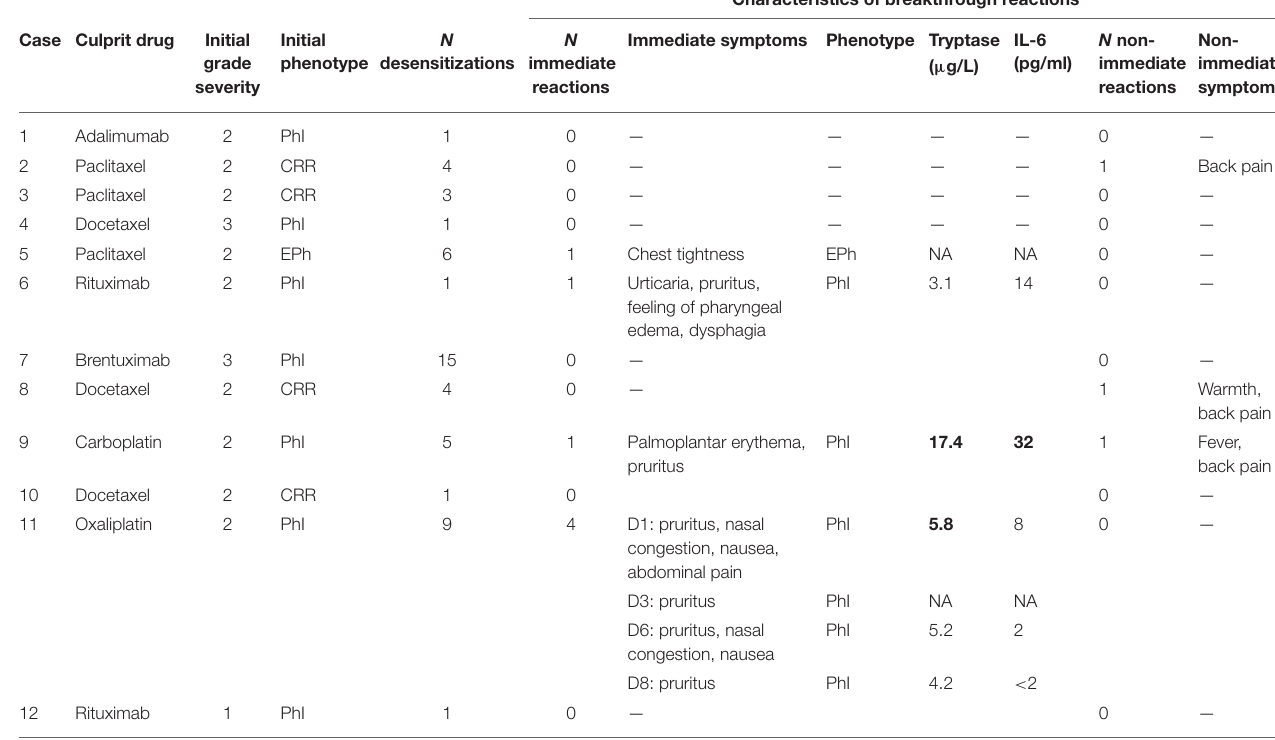
Characteristics of breakthrough